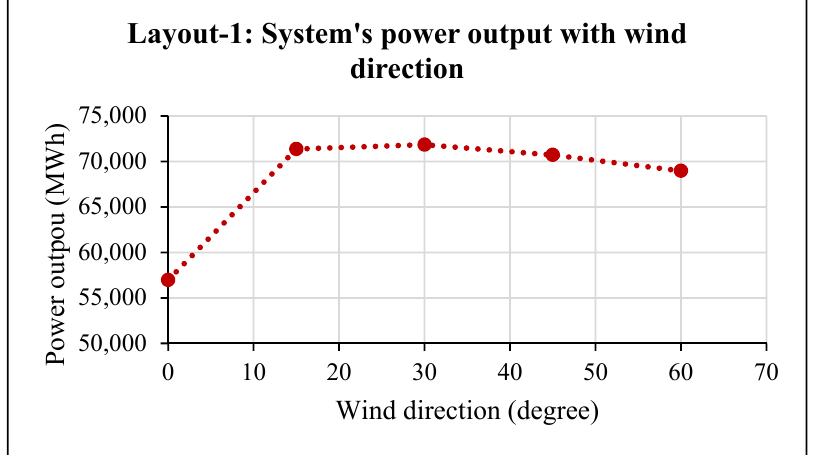
Figure 11. System’s power output for different wind directions. Taking into account the distance between the turbines and the lines assumed in layout 1 of the wind farm, Figures 12 and 13 illustrate the system’s power output and wake losses, respectively. As can be perceived, by increasing the distance, the power can be improved and wake losses reduced, but an excessive increase in the distance between lines can cause a decline in power generation since, in a real wind farm, the decline in power generation is due to both the wake effect and the decrease of the wind mass load. On the other hand, although there is a marked gain in power generation and reduction of wake effect with the distance between turbines from 2D o to 4D o , in contrast to that, with the distance between turbines from 4D o to 8D o , the power generated remains practically constant.